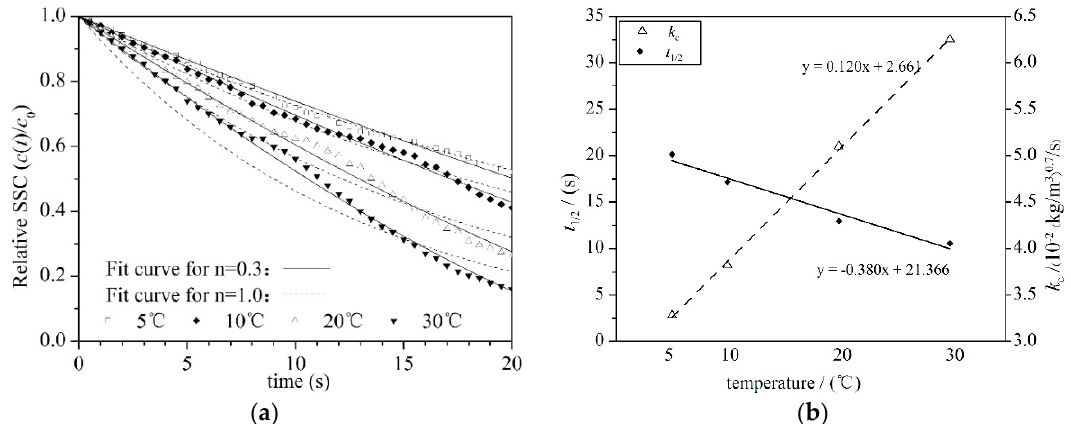
Figure 7. The SSC time series and its relative parameters. ( a ) The time series curves of relative SSC (ratio of c ( t ) at time t to initial c 0 ) of a water system shallower than 4.5 mm; ( b ) The k c in Equation (12) and t 1 / 2 in Equation (13). In ( a ), the symbols are the experiment results, the solid lines and dashed lines are the fitting curves for n = 0.3 and n = 1.0, respectively. In ( b ), the solid square and hollow triangles symbols are t 1 / 2 and k c , both of which are deduced from the solid curves in ( a ). The solid line and dashed line in ( b ) are the linear fittings for t 1 / 2 ( t 1 / 2 = − 0.380 T + 21.366) and k c ( k c = 0.120 T + 2.661).